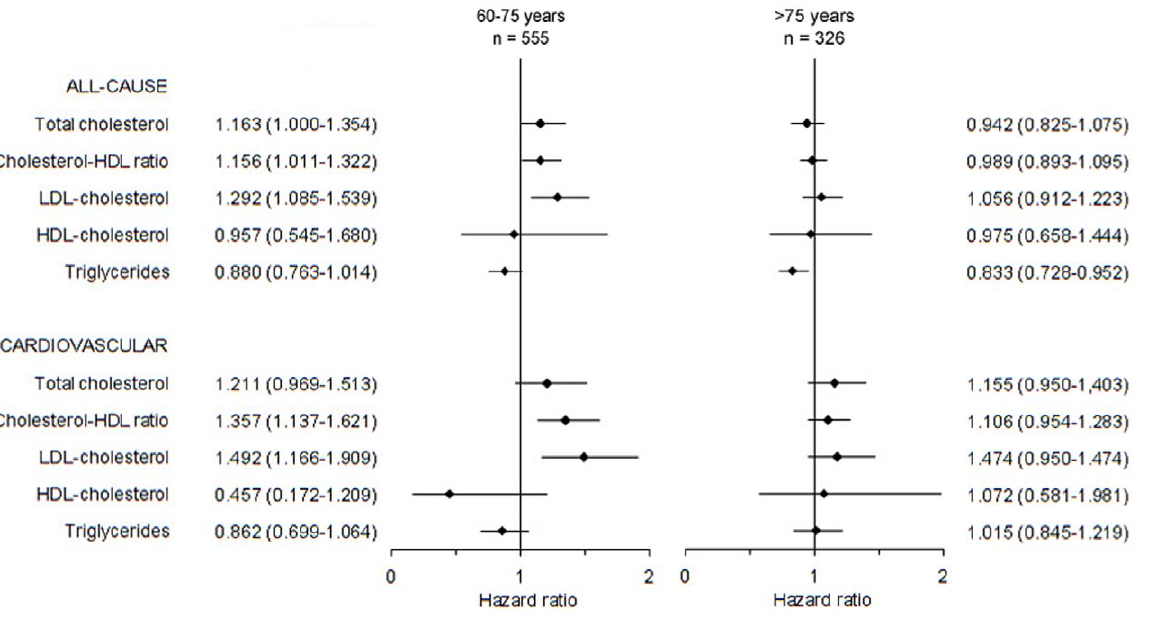
Figure 2. Combined forest plot: lipid profile and mortality. Hazard ratios and the 95% confidence intervals of the various lipid profile indices for all-cause and cardiovascular mortality in both age groups, adjusted for the selected